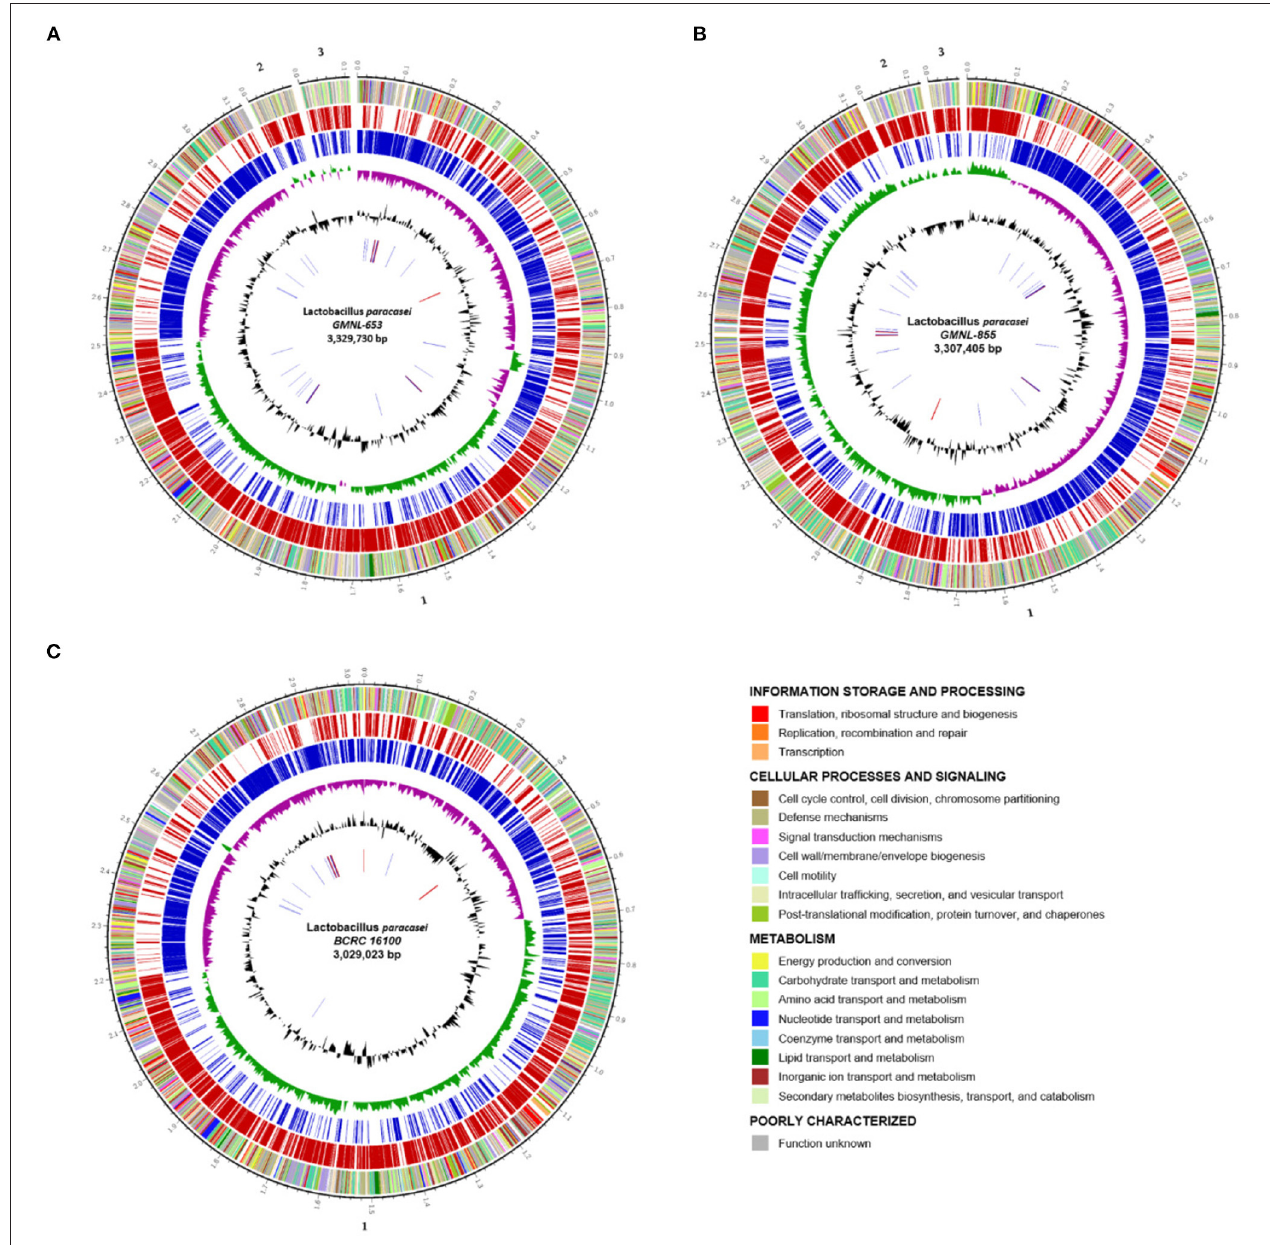
FIGURE 8 | Circular genome graph (A–C) of the L. paracasei strain. (A) The GMNL-653, (B) GMNL-855, and (C) BCRC-16100 genome. The outer to inner circles depict the (1) DNA coordinates; (2) function-based color-coded mapping of the genes, colored according to the COG category whose code and meaning is provided in the table below the plot; (3, 4) coding sequences predicted on the forward (red) and reverse (blue) strands, respectively; (5) GC skew (G – C/G + C), calculated for a window of 4,000 bp and shifted by 1,000 bp over the genome sequence, with the above- and below-average regions indicated in green and purple; (6) GC content (black); and the (7) RNA genes (tRNA, blue; rRNA, red; other RNAs, black).